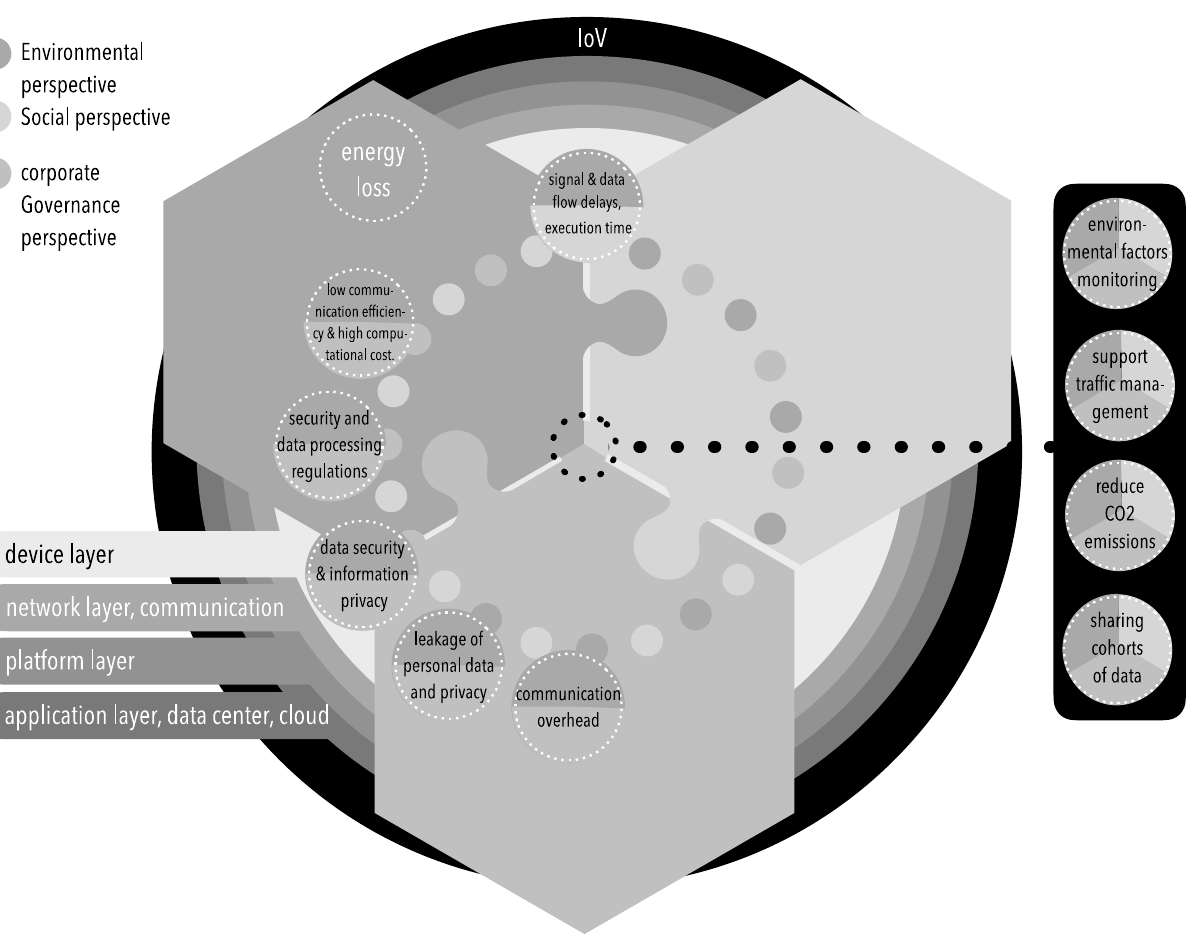
Figure 1. Allocation of ESG perspectives and related issues within the conceptual model of IoV systems. Source: the layer-based architecture of the IoV system based on [174].